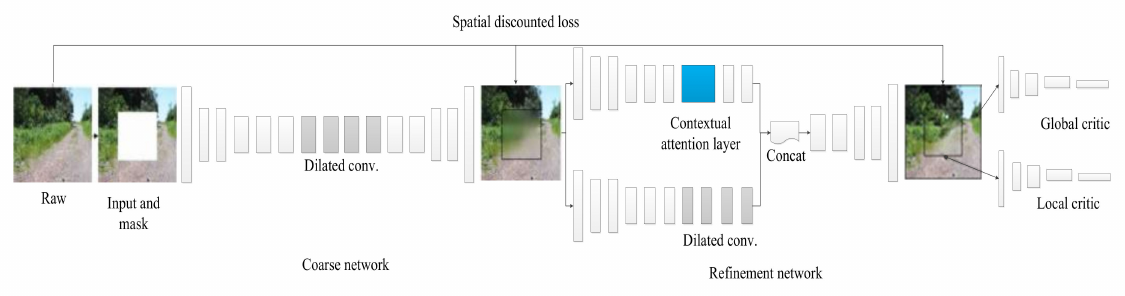
Figure 5. The framework of